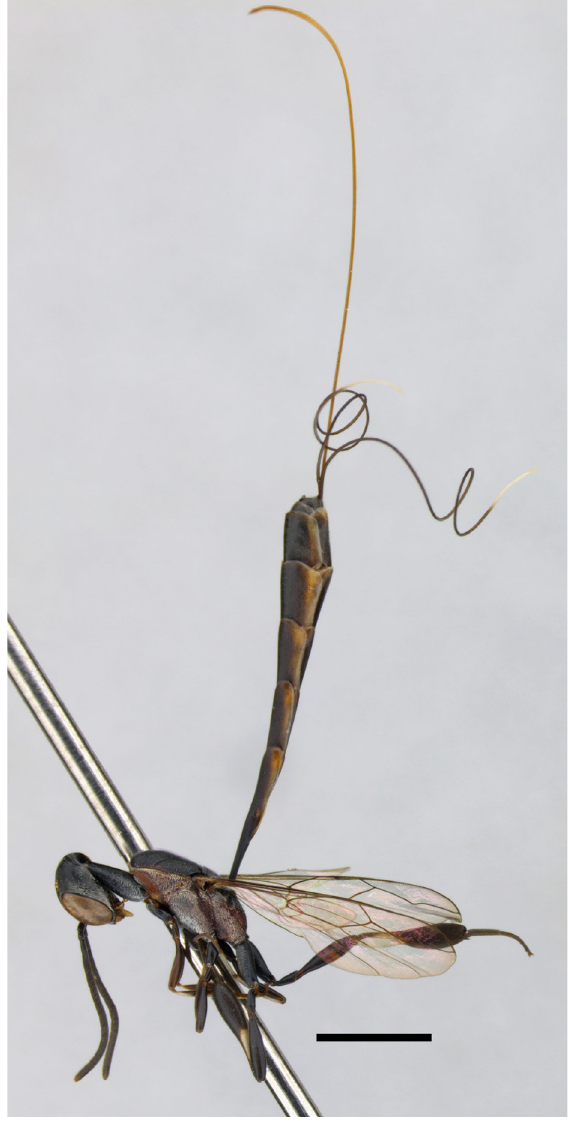
Figure 3. Gasteruption helenae Macedo, 2011, habitus. Scale bar = 2